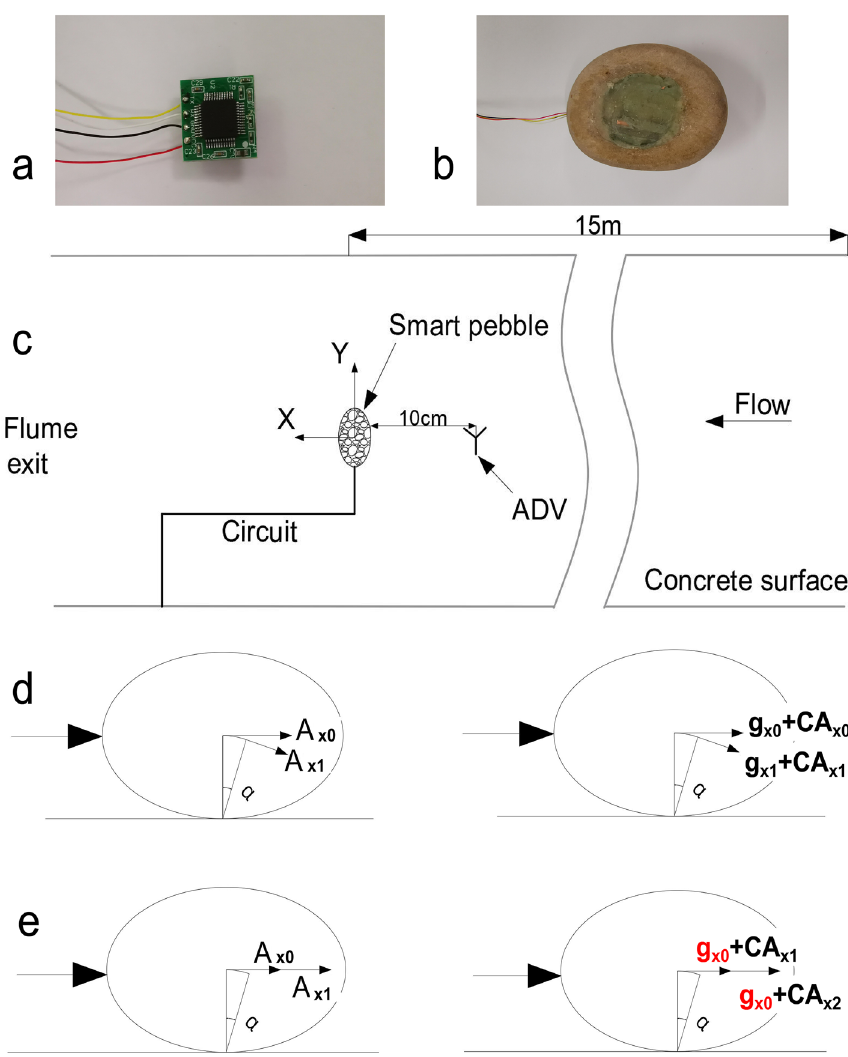
Figure 1. Pictures related to smart pebble test. ( a ) Miniature triaxial acceleration sensor. ( b ) Smart pebble. ( c ) A sketch of the different flume sections (top view). ( d , e ) Vibration process of smart